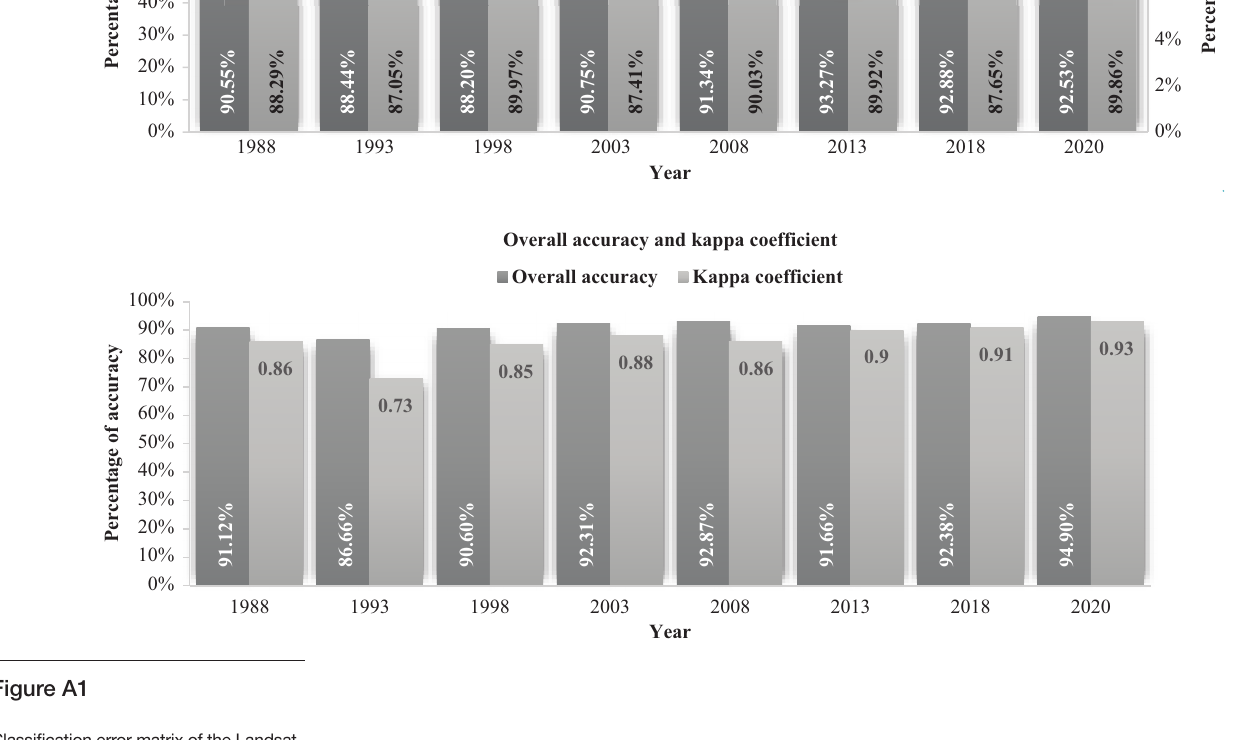
Classification error matrix of the Landsat TM, ETM+ and OLI data for multiple years, 1988, 1993, 1998, 2003, 2008, 2013, 2018 and 2020. The ground reference data used was the 2010 map derived from NAMRIA. The mangrove forests class is donated by ‘MF’ while the class of non-mangrove areas is denoted by ‘NMA’. Additionally, the measure of commission error (type 1 error) is denoted by ‘CE’ while the omission error (type 2 error) is denoted by ‘OE’,